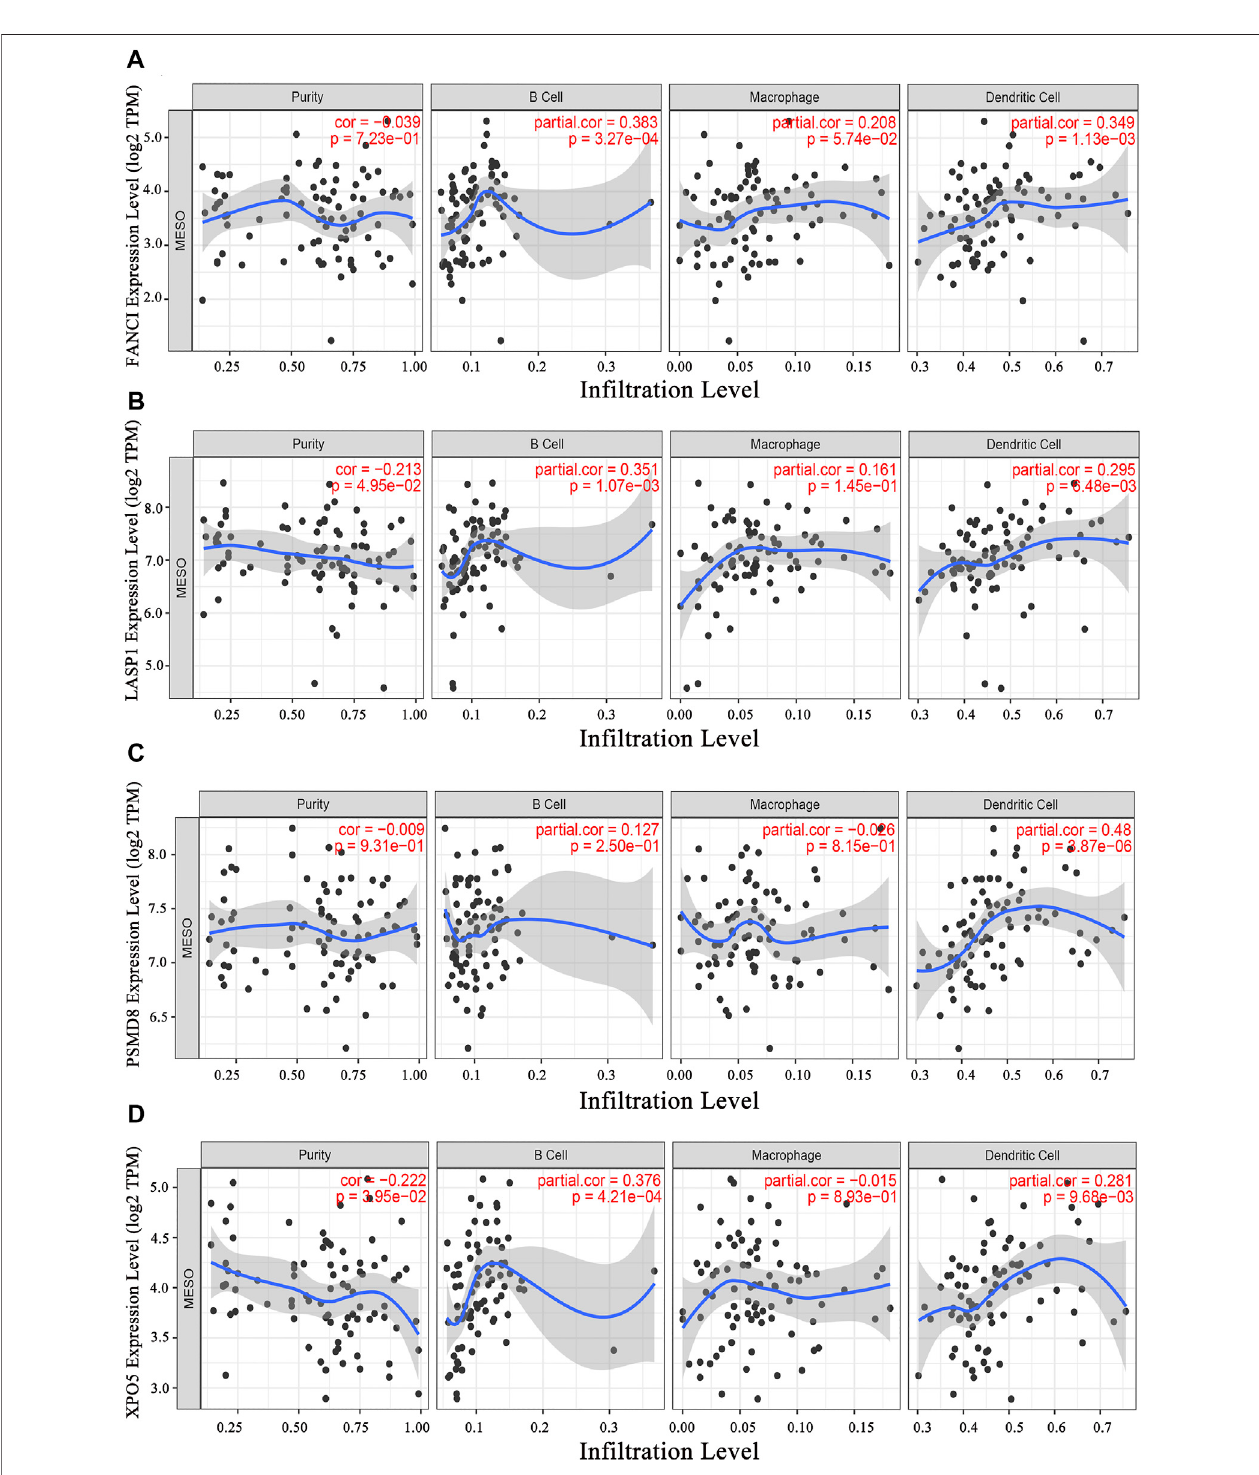
FIGURE 3 | Identi fi cation of tumor antigen candidates related to antigen-presenting cells (APCs). The relationship of the expression of FANCI (A) , LASP1 (B) , PSMD8 (C) , and XPO5 (D) with the immune cell in fi ltration (B cells, macrophages, and dendritic cells).